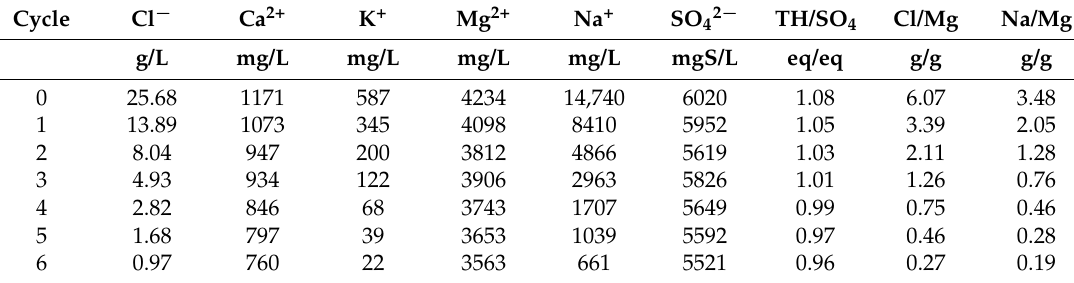
Table 4. Results of applying six DiaNF counter current cycles on the retentate obtained from the NF